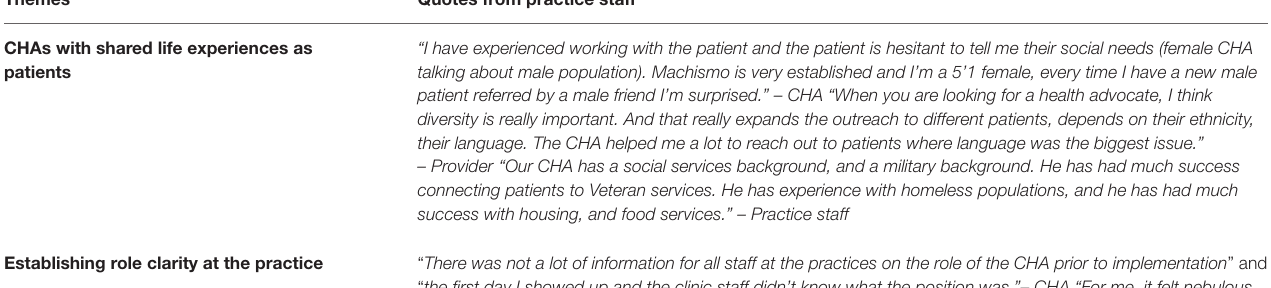
Establishing role clarity at the